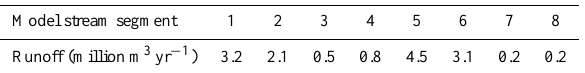
Fig. 6. Schematic cross-section of the San Diego River basin groundwater flow model domain showing generalized vertical model structure, land-surface elevation, and depth to groundwater. Table 2. Runoff estimated from Basin Characterization Model, BCM run , accumulated for each stream segment, and applied using Streamflow Routing Package.